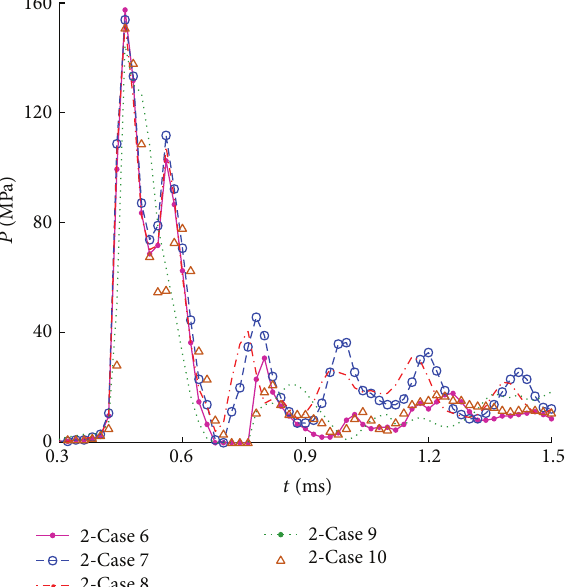
Figure 15: The pressure of test point B; 2 means full interlayer water; cases are shown in Table 10.